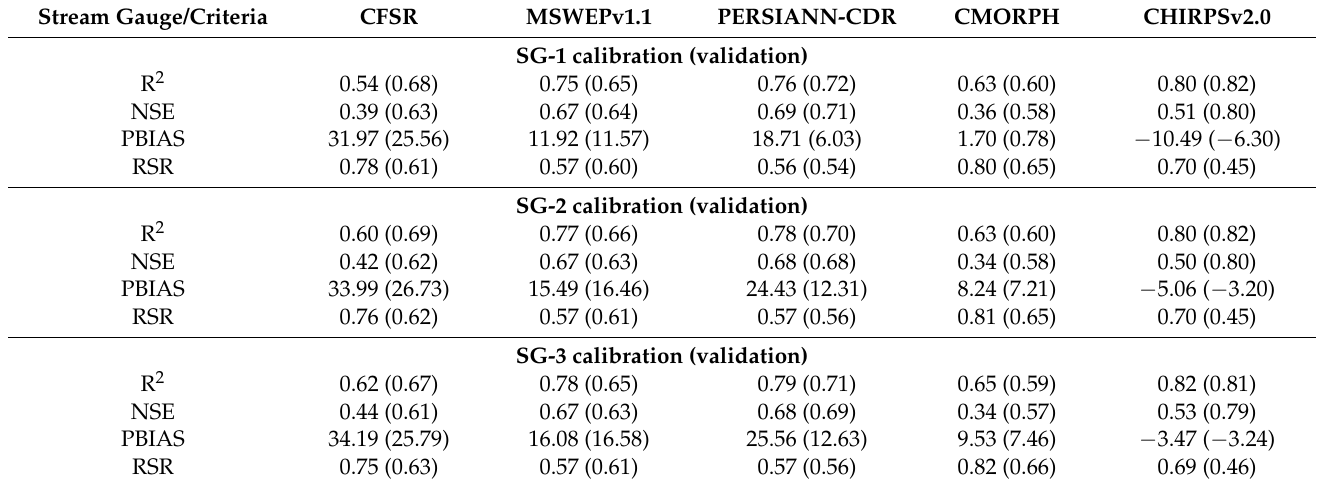
Table 9. Performance of SWAT simulations on a monthly scale derived with the best-fitted parameters calibrated with precipitation gauge stations for calibration (2005–2007) and validation (2008–2010) for three gauge stations. Stream Gauge/Criteria CFSR